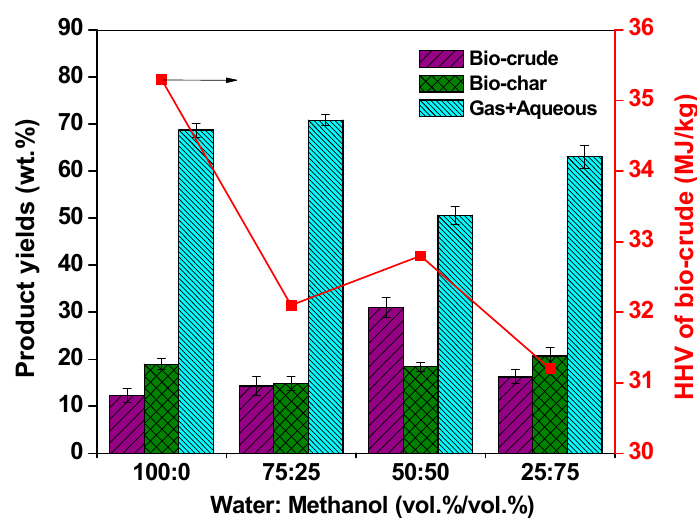
Figure 3. Effect of water-to-methanol ratio on product yields and HHV of bio-crude at a final temperature of 300 °C, 60 min reaction time, and rice-straw-to-solvent ratio of 1:10 wt./wt. In order to ascertain the quality of bio-crudes obtained by using methanol as co-solvent, the elemental composition and HHVs were analyzed. From Table 4, it is clear that the oxygen content in bio-crude is, in fact, higher (17.8–22.3 wt.%) as compared to that obtained with only water as the